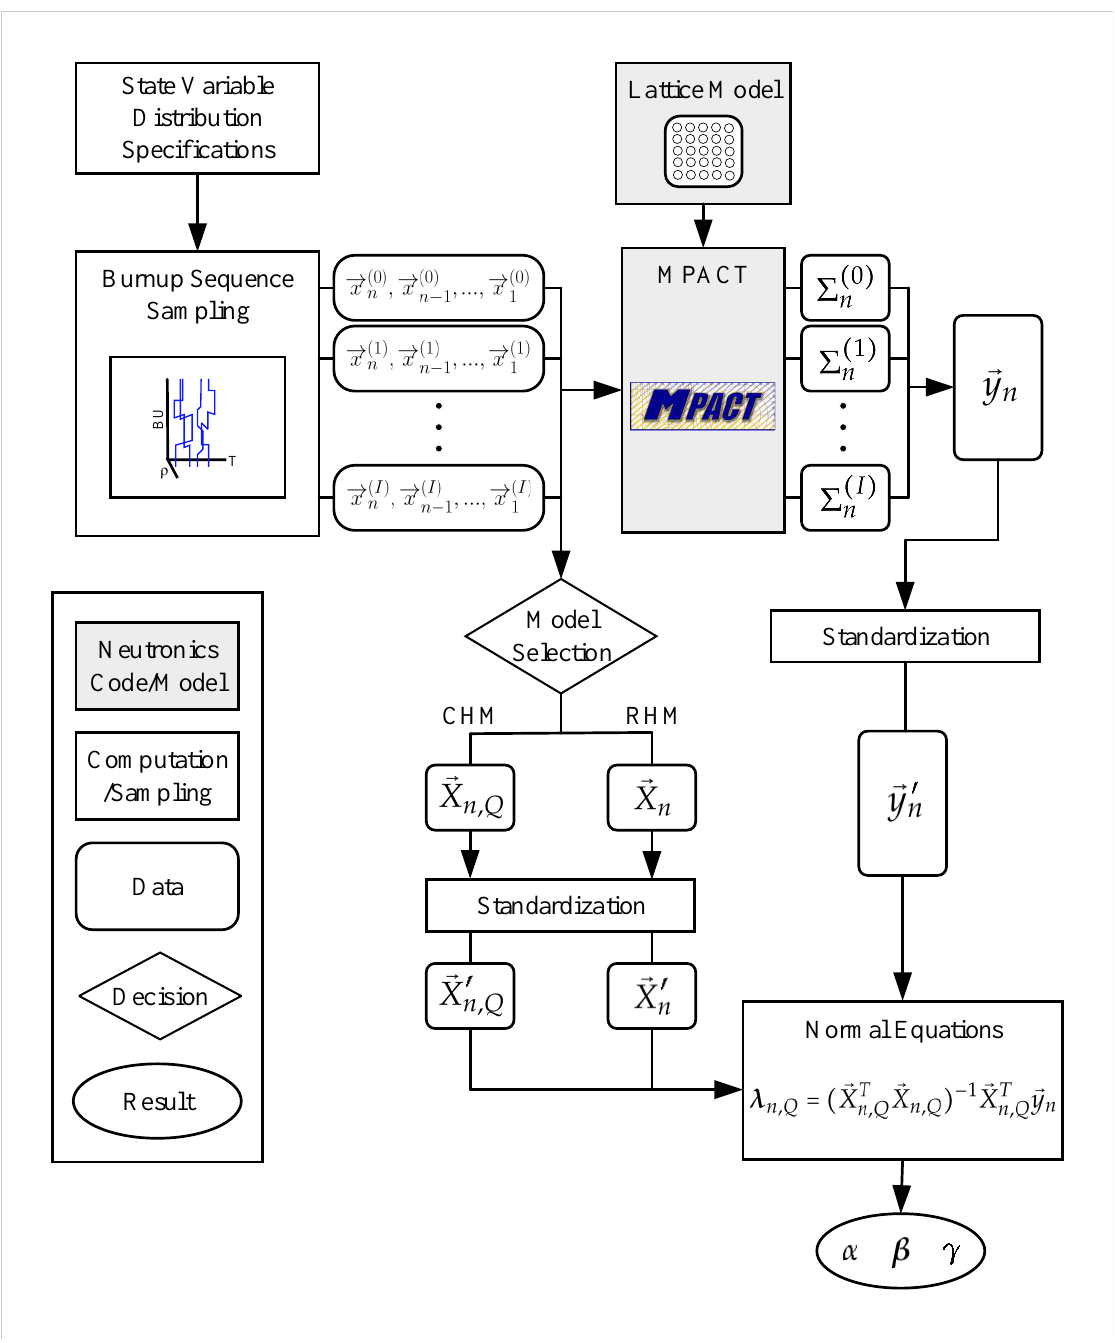
Figure 3. Potential workflow to execute the proposed methodology to obtain sensitivity estimates for some HXS at some burnup step n